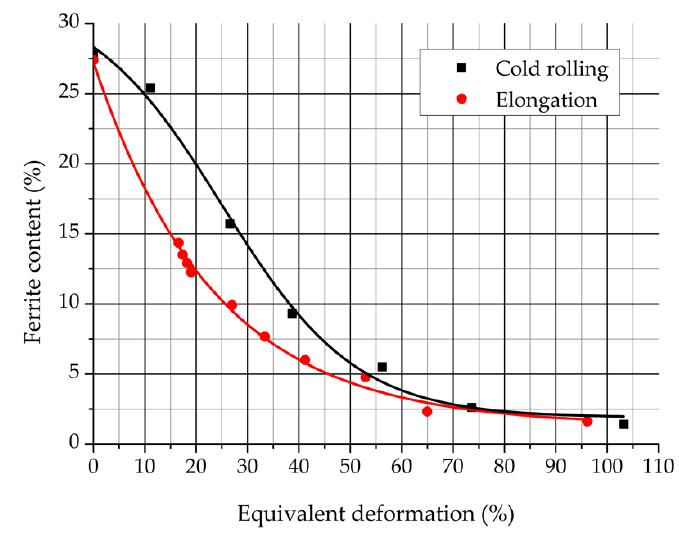
Figure 21. The equivalent deformation in function of the δ -ferrite content.